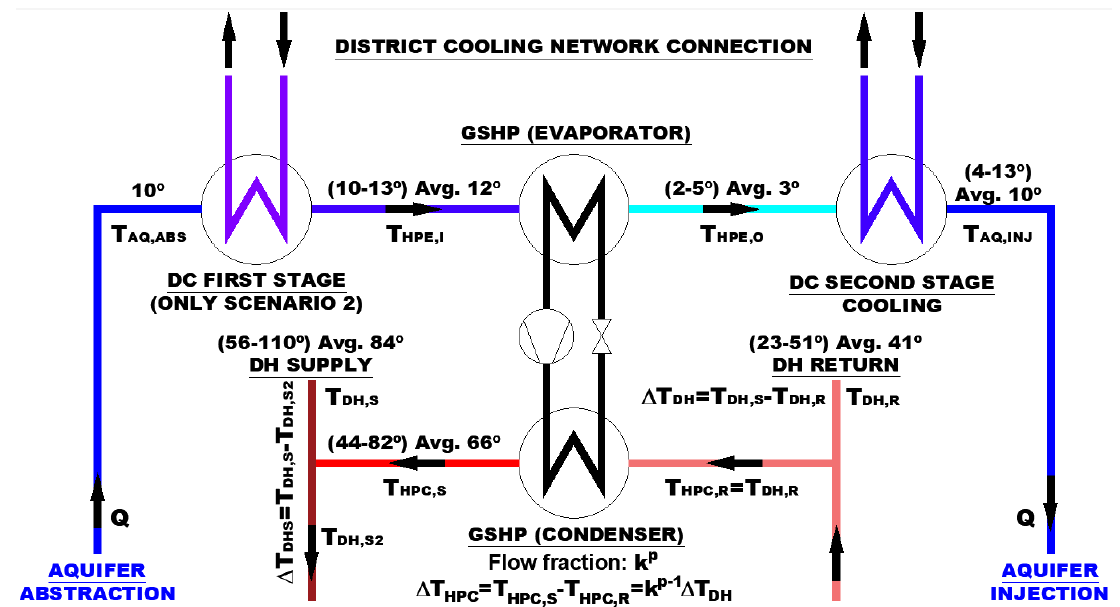
Figure 3. General scheme of ATES integration in DH–DC networks.